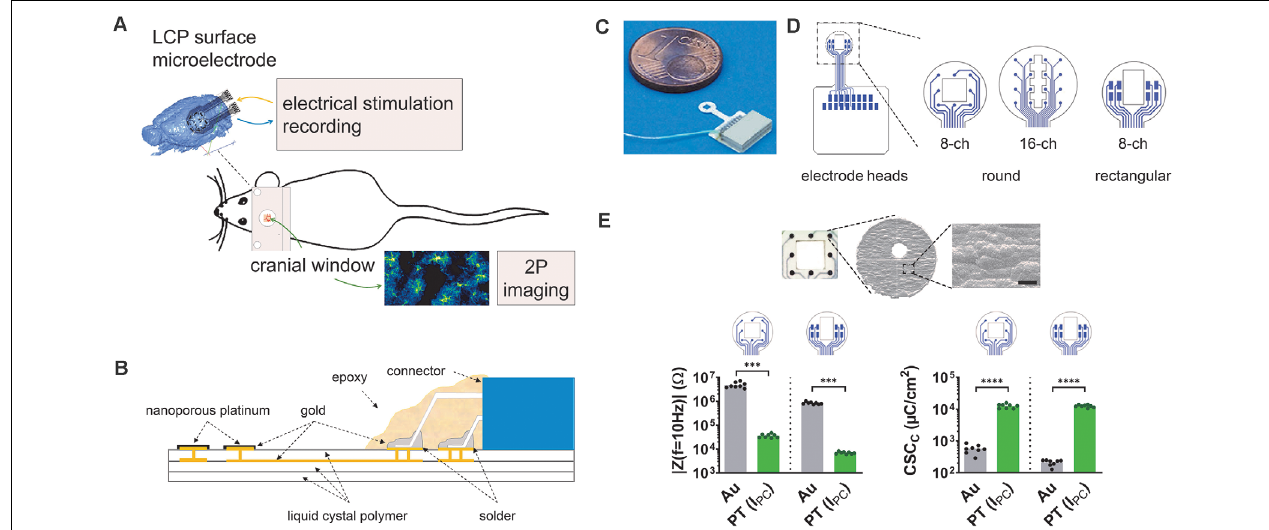
FIGURE 1 | Development of liquid crystal polymer (LCP) surface electrodes for in vivo studies combining electrophysiology and imaging. (A) Flexible yet robust surface microelectrodes, applicable for in vivo investigation of electrical brain stimulation, electrocorticographic recording of brain activity, and 2P-imaging of Ca 2+ signals. (B) Electrode structure with an LCP base including golden electrical structure and superficial gold electrodes, electroplated with nanoporous platinum. The nano-connector is soldered to the terminal pads and secured with epoxy resin. (C) Fully assembled LCP surface microelectrode. (D) Three different electrode arrays with eight or 16 circular electrodes (3 mm or 4 mm in diameter) for ECoG recording or eight rectangular electrodes for stimulation. Circular electrode sites are 150 µ m in diameter; the size of rectangular-shaped sites is 400 µ m × 200 µ m. The two 8-channel electrode configurations have a spare square in the center (1 mm × 1 mm or 1 mm × 1.5 mm), the 16-channel electrode has a polygon (length 2.8 mm; small width: 400 µ m; large width: 800 µ m), allowing 2P-imaging. (E) Top: scanning electron micrograph of a single electrode site showing the surface structure, scale bar = 5 µ m. Bottom: typical magnitude of electrode impedance at a frequency of 10 Hz (|Z( f = 10 Hz)|) and typical cathodic charge storage capacity (CSC C ). Compared with the gold electrode sites, platinum-coated sites display a lower impedance enabling recordings with less noise and a higher CSC C allowing for higher stimulation currents. Statistics: | Z( f = 10 Hz) |: Mann–Whitney test and CSC C : unpaired t -test ∗∗∗ p < 0.001, ∗∗∗∗ p < 0.0001. N = 8 measurements per